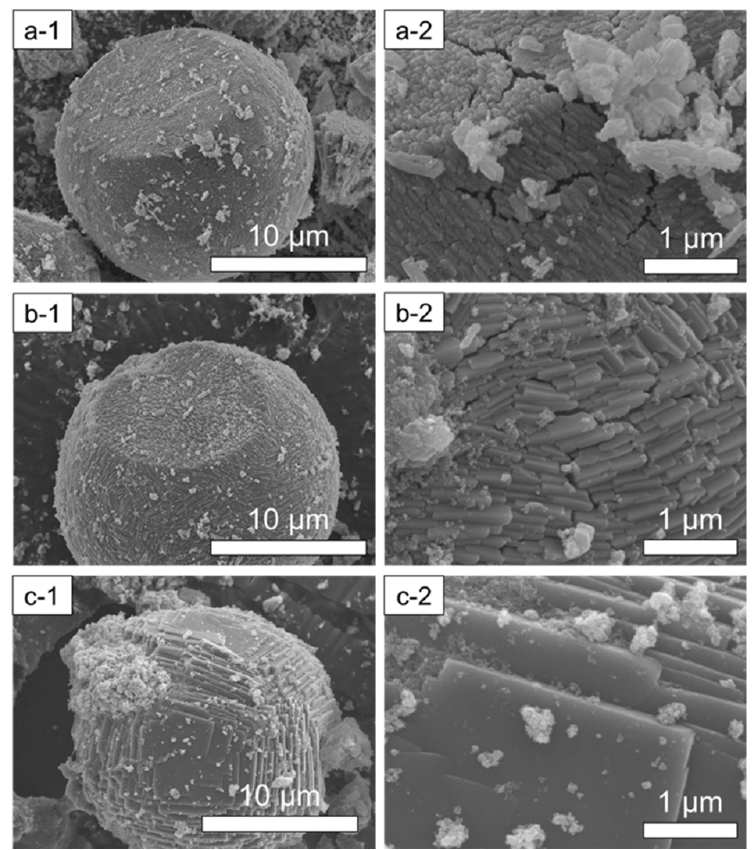
Figure 8. SEM images of SAPO-18 obtained under AP ( a-1 , a-2 ), 50 MPa ( b-1 , b-2 ) and 200 MPa ( c-1 , c-2 ) using the concentrated synthesis mixture (H 2 O/Al 2 O 3 =